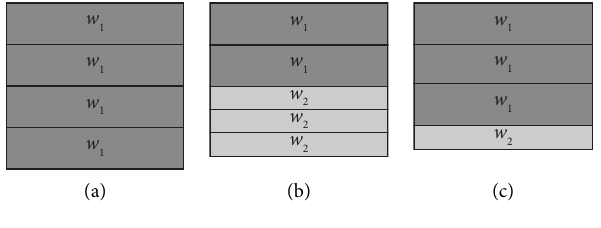
Figure 3: Blank layout method